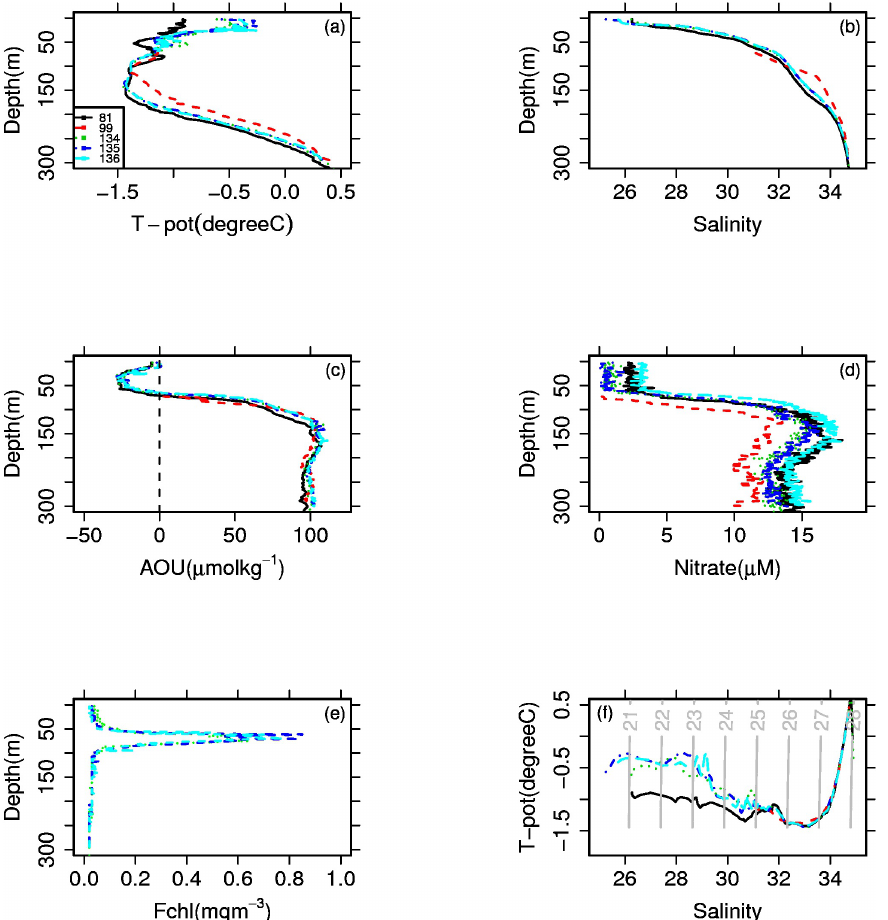
Fig. 3. Observed hydrography of the Arctic Ocean during the MALINA cruise. (a) Potential temperature (in ◦ C), (b) Salinity, (c) Apparent dissolved oxygen utilization (AOU) concentration (in µ molkg − 1 ) , (d) Nitrate concentration (in µ M), (e) chlorophyll fluorescence, F chl (in mgm − 3 ) , and (f) T-S diagram. These profiles were obtained at deep stations (bottom depth > 1000m; see Fig. 1 for location) as representatives of typical hydrography of the Western Arctic Ocean. F chl at stations 81 and 99 were not